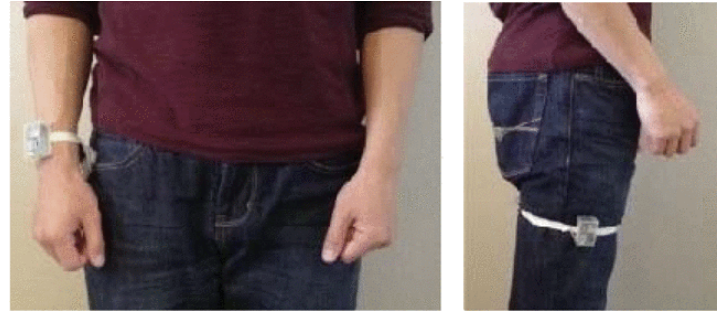
Figure 5. Wearable inertial sensor placements [21].